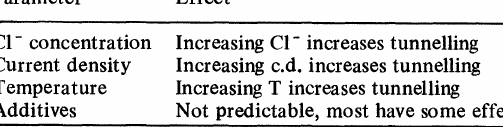
FIGURE 10 Schematic representation of the cube withdrawal model. TABLE II Influence of electrochemical parameters on degree of